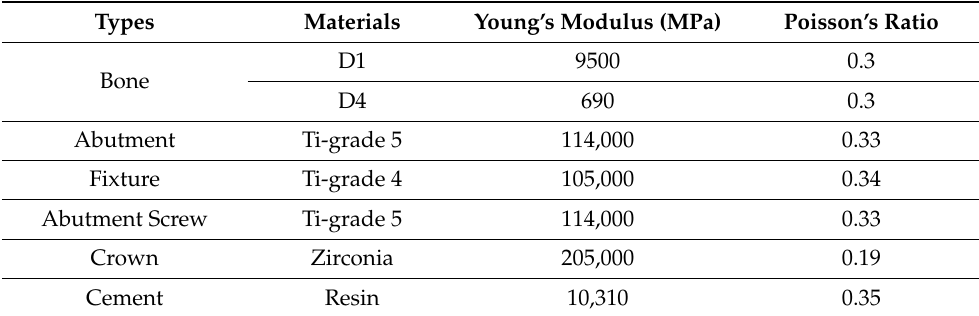
Figure 2. Multi-cross-sectional view of second molar surgical model with two surgical techniques. Each surgical model consists of abutment, fixture, abutment screw, crown, cement and bone. The bone was divided into three regions of ①–③ according to height. ( a ) Surgical model using cortical tapping, ( b ) Surgical model using cortical widening. Table 1. Material properties of the FEA model.